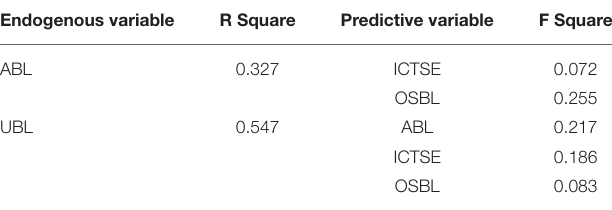
TABLE 6 | Predictive relevance and effect size. Endogenous